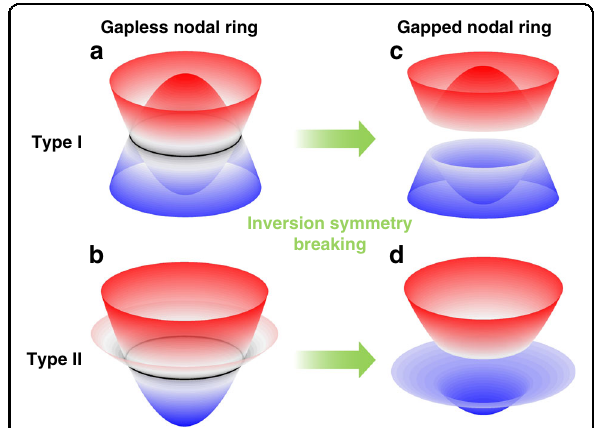
Fig. 1 Schematics of type-I and type-II Dirac nodal rings. a , b Gapless nodal rings protected by inversion symmetry. c , d Gapped nodal rings after inversion symmetry breaking which exhibit ridge-like